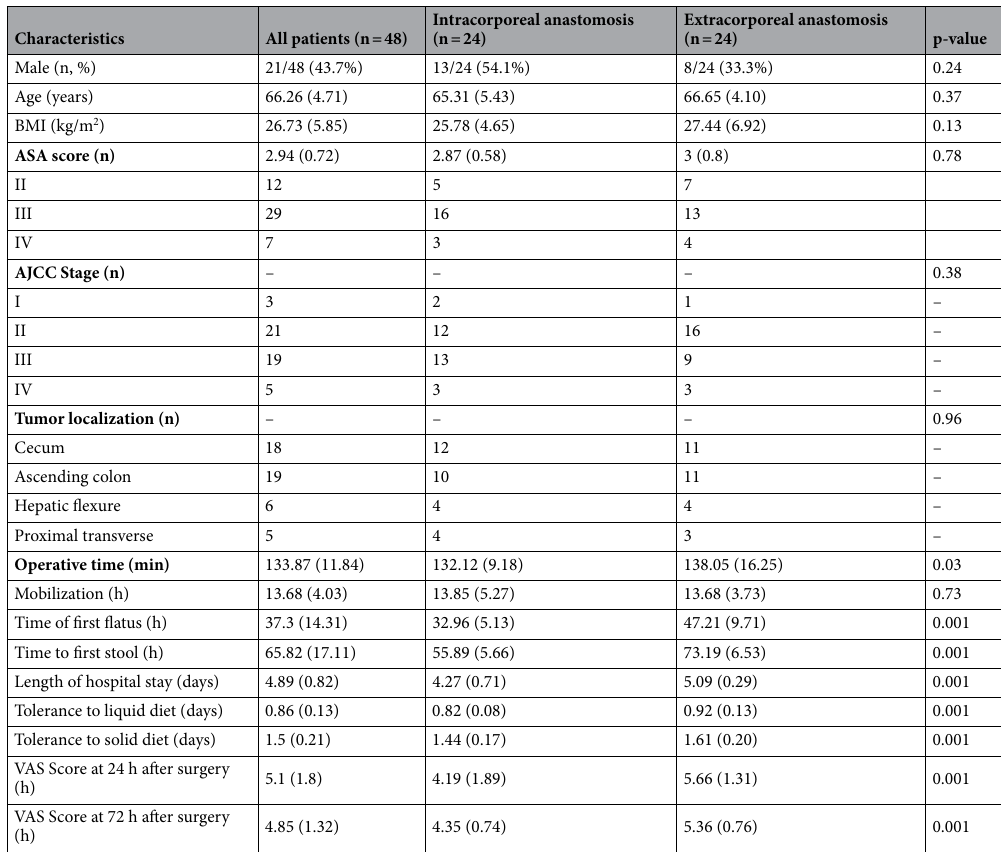
Table 3. Demographic characteristic and recovery outcomes of patients without post-operative complications. Data were expressed as median (interquartile range) where not differently indicated. BMI body mass index, ASA American Society of Anesthesiologists, AJCC American Joint Committee on